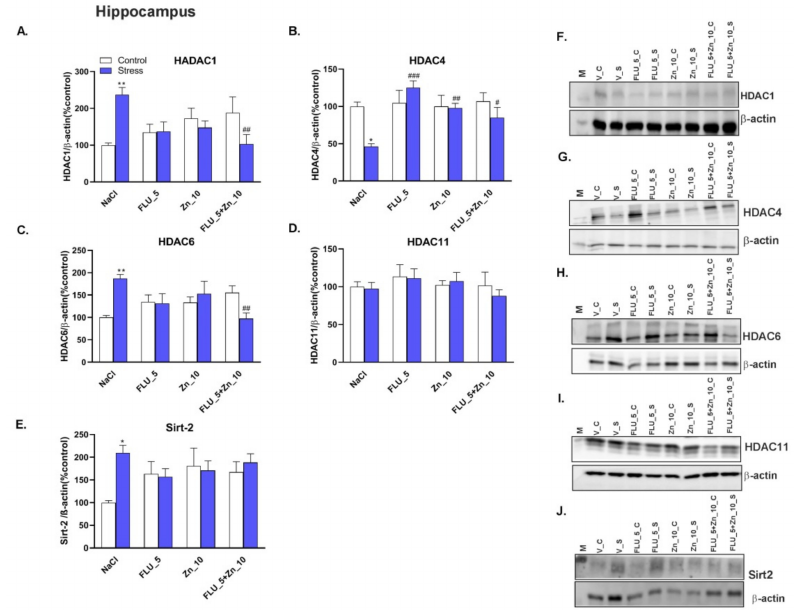
Figure 9. The combined effect of Zn supplementation and FLU treatment on the levels of protein of HADC1 ( A ), HADC4 ( B ), HDAC6 ( C ), HDAC 11 ( D ), and Sirt2 (E) in the Hp of CRS-treated mice. All data were analyzed by two-way ANOVA and Newman–Keuls multiple comparison test. Values are expressed as mean ± SEM; n = 8. * p < 0.05, ** p < 0.01 vs. NaCl, # p < 0.05, ## p < 0.01, ### p < 0.001 vs. CRS + NaCl. ( F – J ) Representative Western